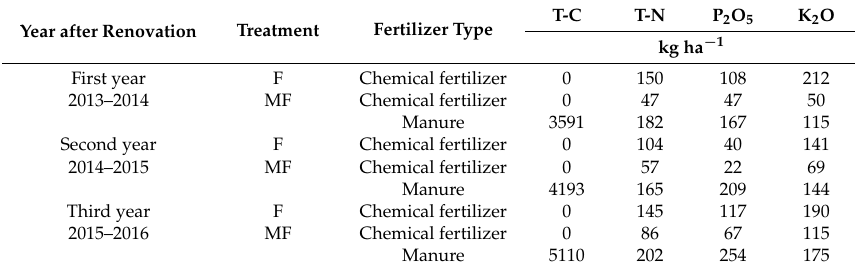
Table 2. Annual chemical fertilizer and manure application rate after renovation in chemical fertilizer treatment (F) and combined manure and chemical fertilizer treatment